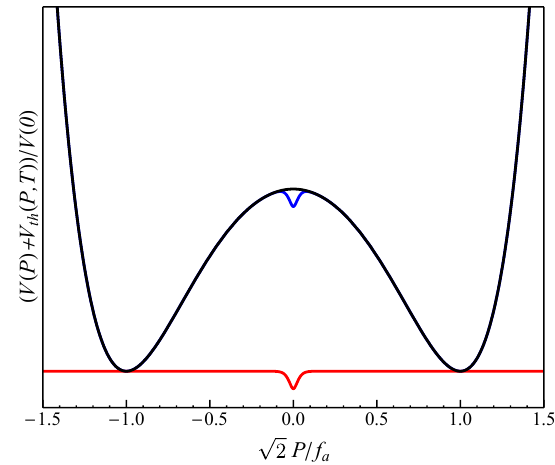
Figure 1 . The solid black line is the vacuum potential of P as given in eq. (2.5) with n = 3. The solid red line is the thermal correction to the vacuum potential that has been exaggerated to emphasize the structure. The blue line is the sum of the vacuum potential and exaggerated thermal